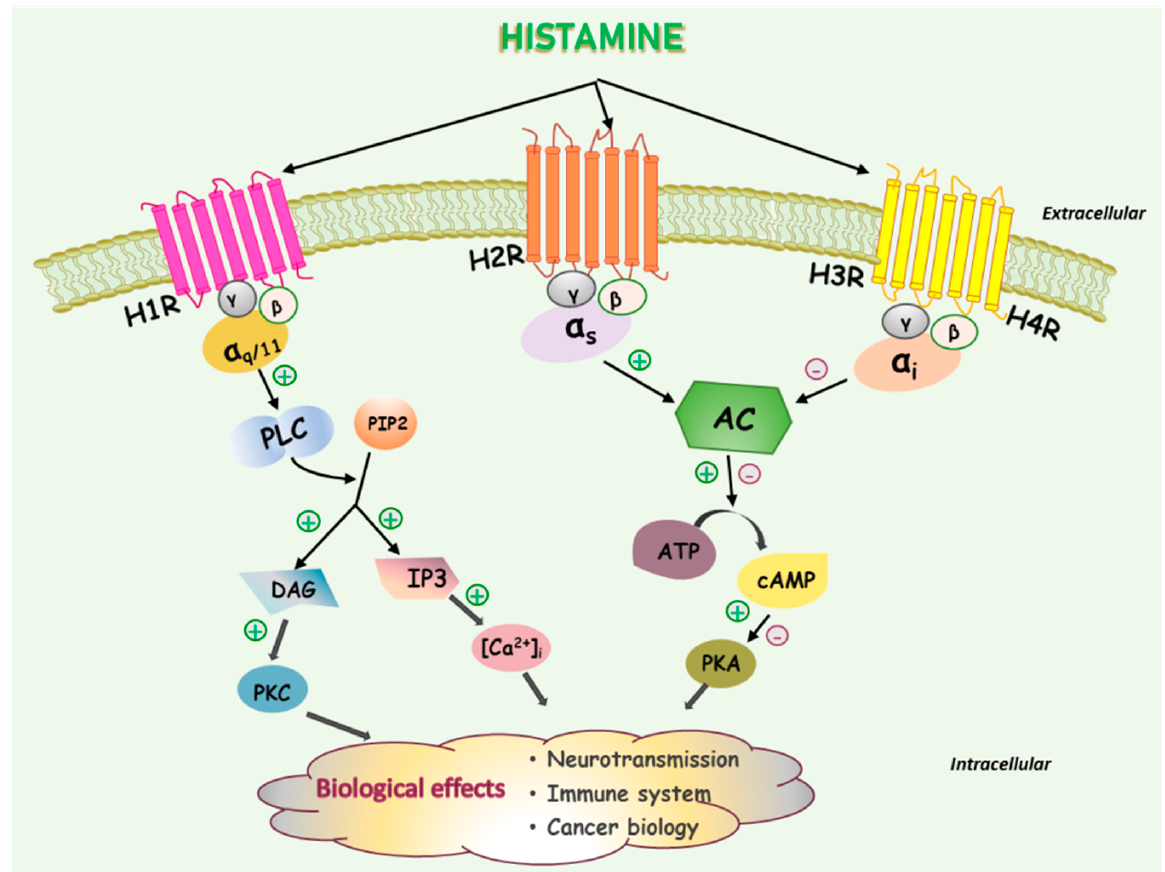
Figure 1. Signaling pathways mediating the biological effects of the histamine receptor subtypes. Each receptor is activated by endogenous histamine. The biological effects depend on the HR subtypes and cell types. H1R: histamine H1 receptor; H2R: histamine H2 receptor; H3R: histamine H3 receptor; H4R: histamine H4 receptor; PLC: phospholipase C; PIP2: phosphatidylinositol 4,5-bisphosphate; DAG: diacylglycerol; IP3: inositol 1,4,5-trisphosphate; [Ca 2+ ] i : intracellular calcium; PKC: protein kinase C; PKA: protein kinase A.